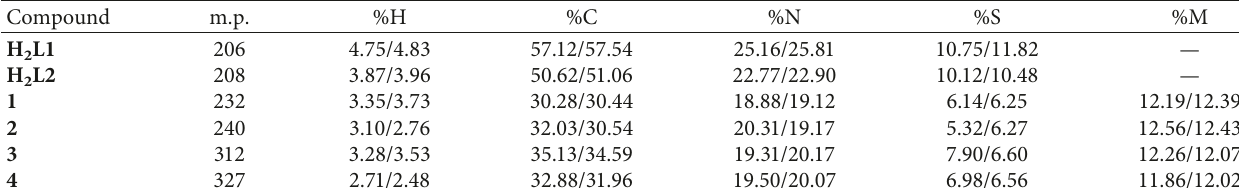
Table 3: Melting points and elemental analysis of the obtained